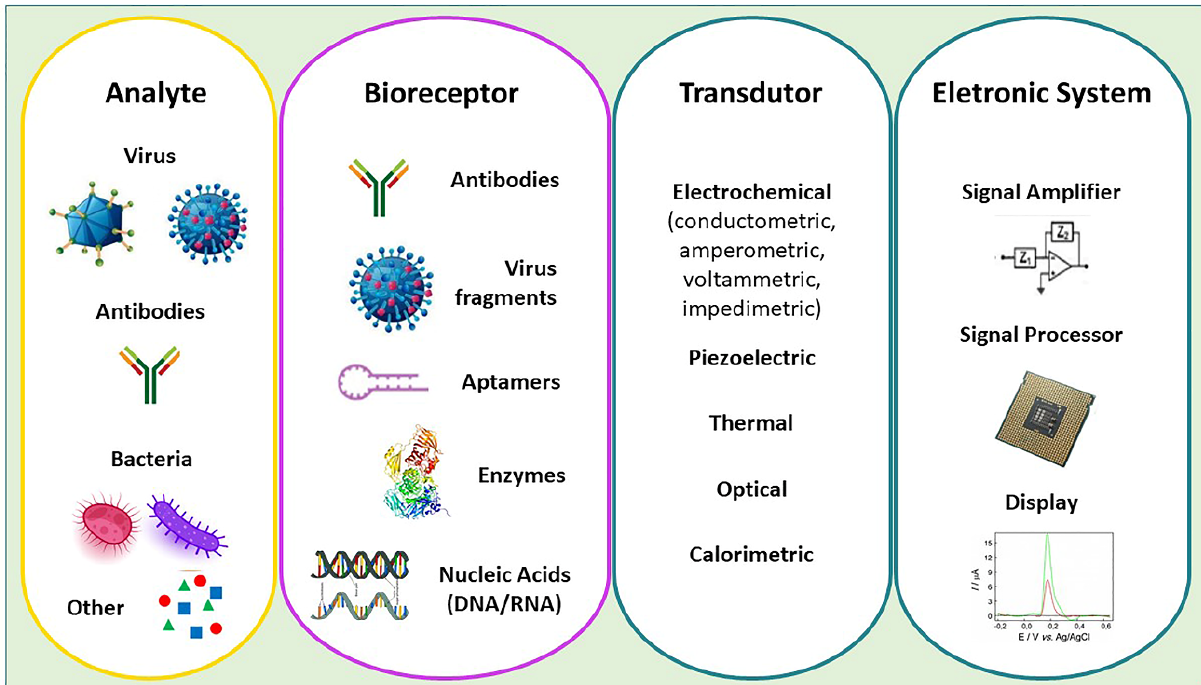
Figure 2. Components of an electrochemical biosensor.